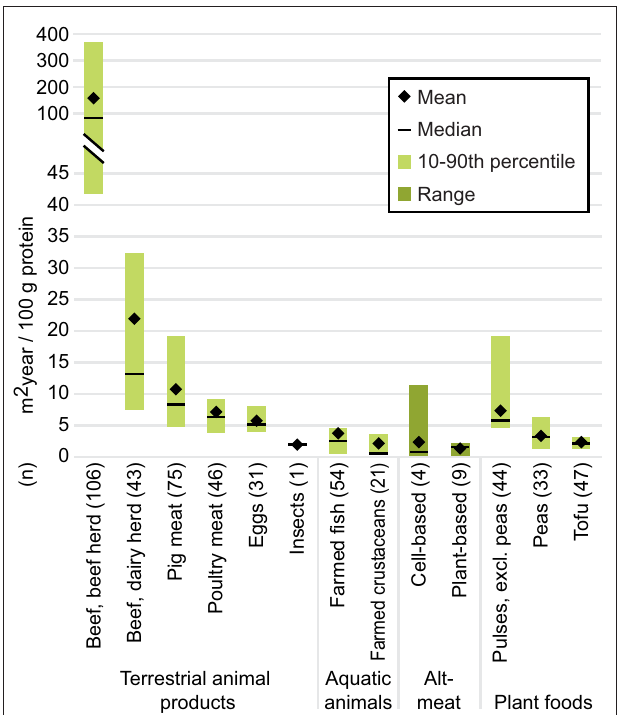
FIGURE 4 | Land use per 100g protein. For cell-based meat, plant-based substitutes, and insects, the mean and median were calculated using the mean value from each individual study ( n ) to avoid over-representing results from studies that included more products than other studies. The minimum and maximum values of the range were derived from individual product footprints. For data sources and individual product footprints, see Supplementary Data . Data for all other foods are from Poore and Nemecek (2018); for these n represents the number of observations.